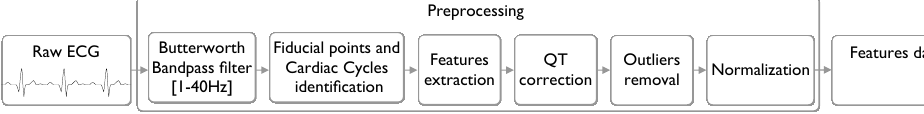
Figure 2. Preprocessing